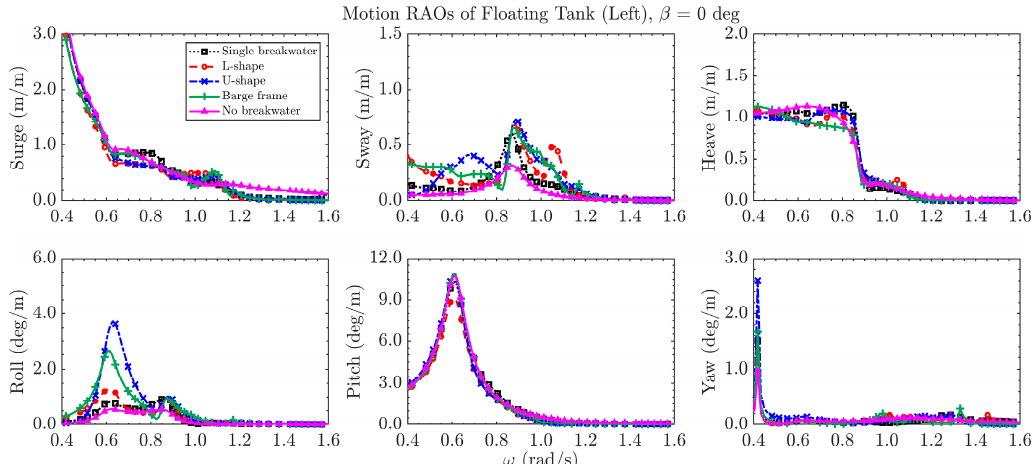
Figure 10. Motion RAOs of the floating breakwaters of different configurations in heave, roll, and pitch with the presence of two floating tanks in 0 and 45 deg incident wave directions.